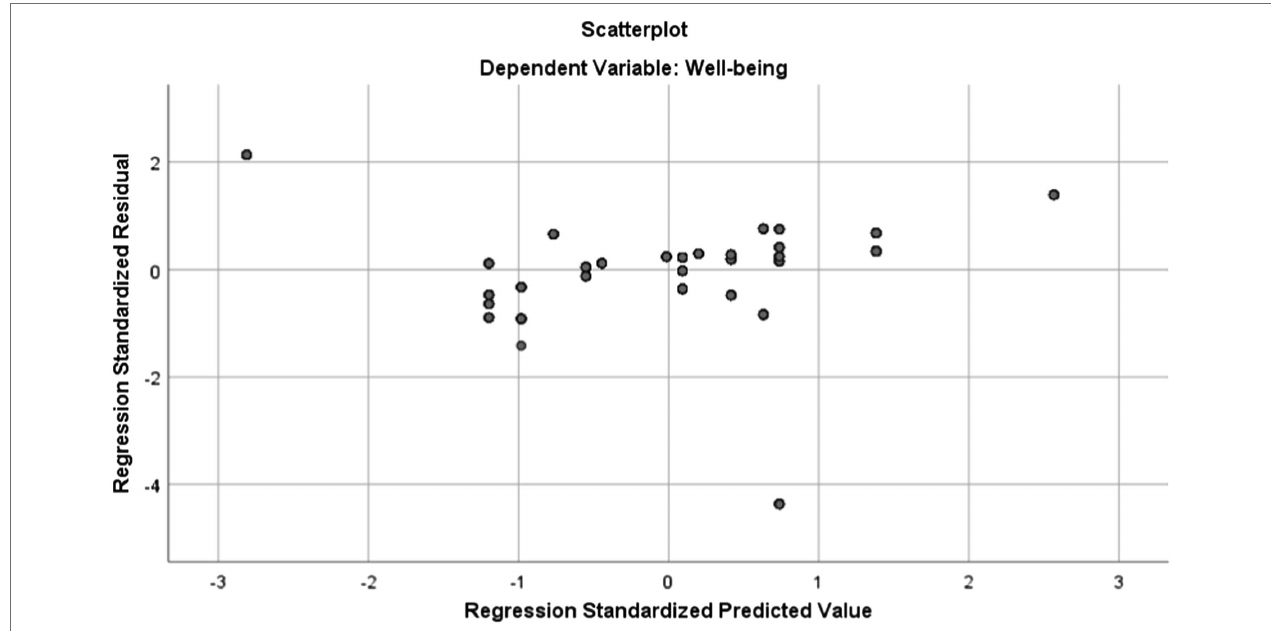
FIGURE 2 | Scatter plot with teachers’ wellbeing as dependent variable.